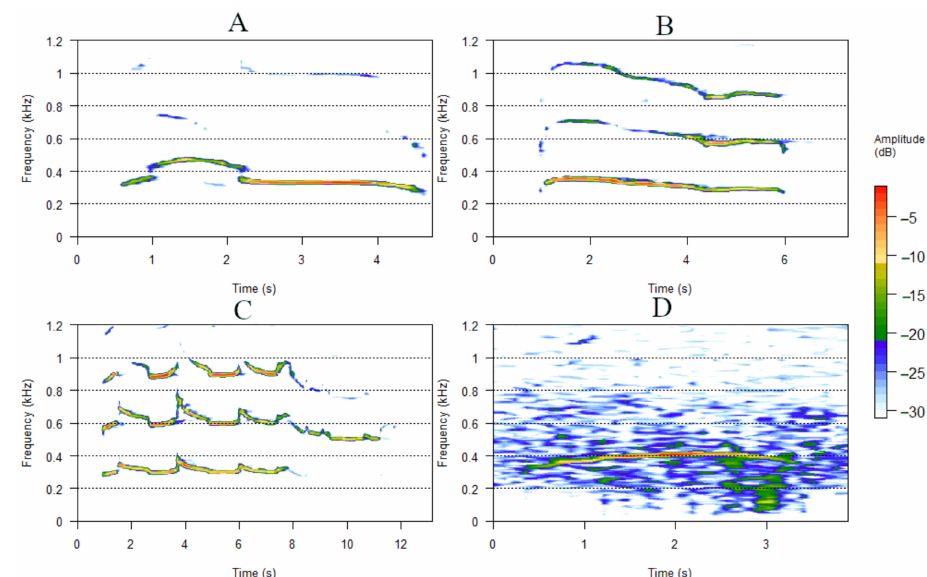
Figure 1. Example of spectrograms of single howls from ( A ). Northwestern wolves; ( B ). Arctic wolves; ( C ). Captive Eurasian wolves; and ( D ). Eurasian wolves with noise. The y -axis shows the frequency in kHz and the x -axis shows the time in seconds. Colors indicate the amplitude of the howls in dB (decibel). The lowest band in the spectrograms are the fundamental frequency (f0) and the other two are the second and third harmonic, which are visible in ( A – C ). The amplitude is in negative dB as 0 is referring to the maximum sound [51]. Graphs were made in the program RStudio [52] using the package Seewave